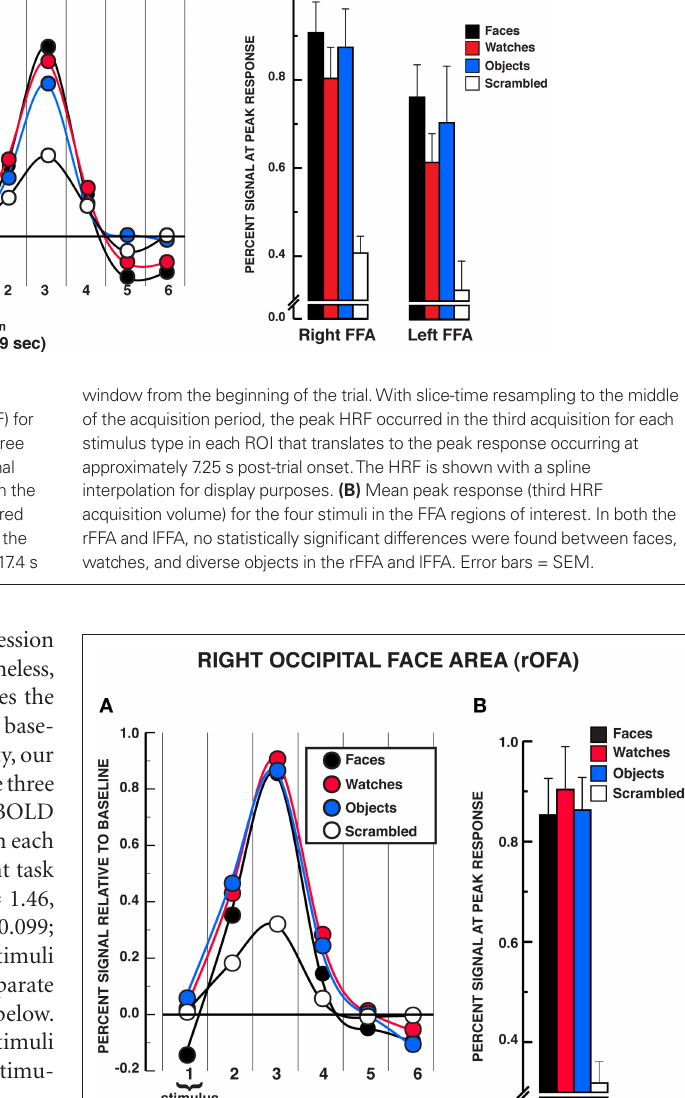
FIguRe 4 | FMRI BOLD results from the individuation task in the right OFA region of interest. (A) Estimated hemodynamic response function (HRF) for the faces, watches, diverse objects, and scrambled stimuli (mean from three individuation task runs) in the rOFA. See Figure 3 for detailed description of HRF function. (B) Mean peak response (third HRF acquisition volume) for the four stimuli in the rOFA region of interest. The results are virtually identical to those observed in the rFFA in that no statistically significant differences were found between faces, watches, and diverse objects in the rOFA. Error bars =